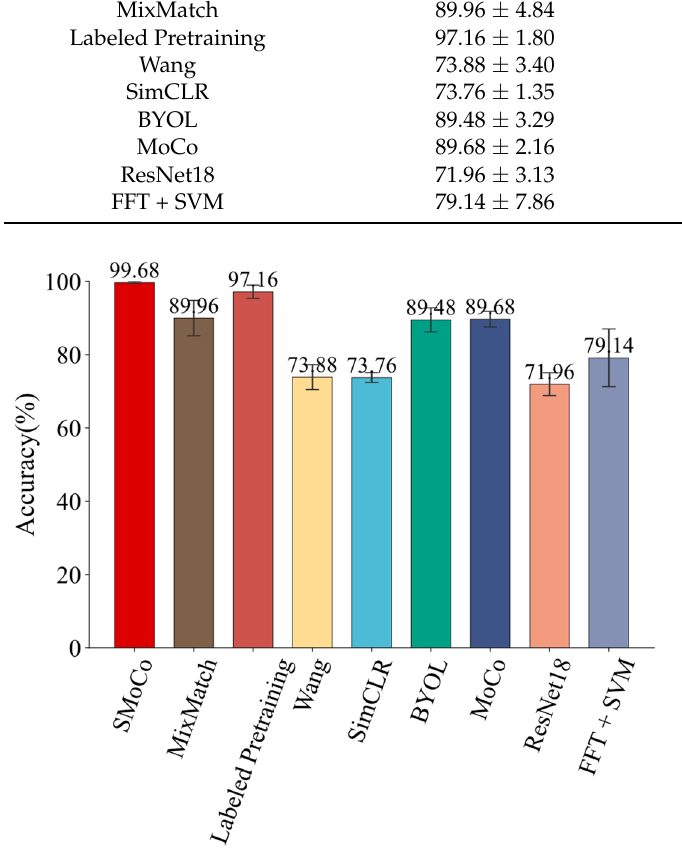
Figure 10. Comparison of diagnostic results on dataset 2 under 5 samples per class.